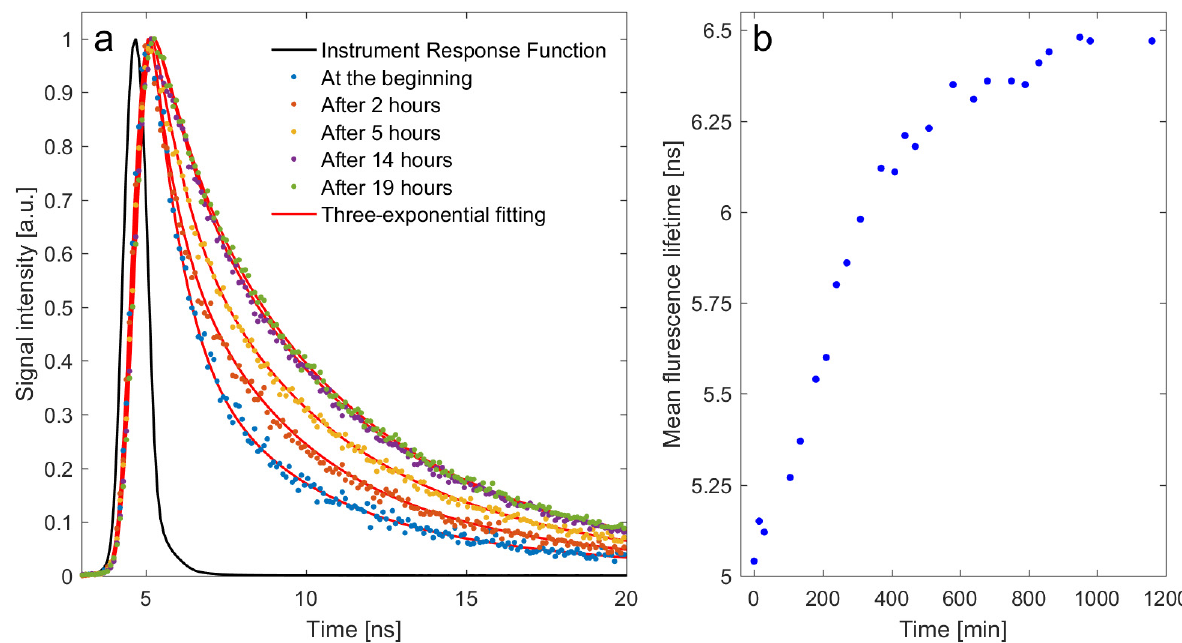
Figure 3. ( a ) The normalized fluorescence decay curves of ALEs-HSA at 450 nm at different times of incubation after the addition of MDA to HSA. ( b ) Mean fluorescence lifetime dependence on time of incubation HSA with MDA.